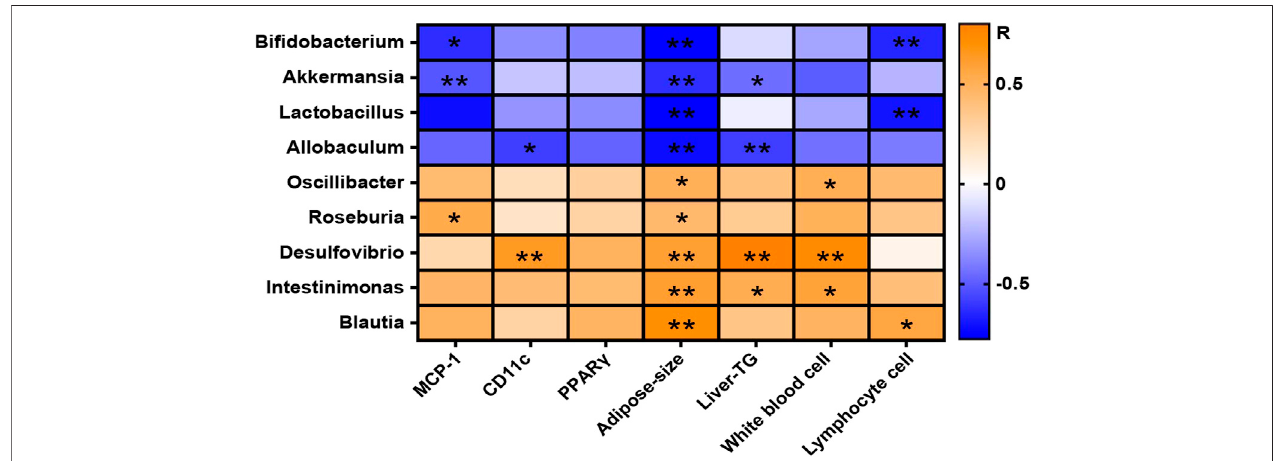
FIGURE 9 | Correlation between gut microbiota and physiochemical indices among experimental groups. After the treatment with NCD, HFD, and/or GlcN (1 mg/ ml, in drinking water) for 5 months, all mice were sacri fi ced and the cecal contents were collected for 16S rDNA sequencing. The correlation between changed gut microbiotaat thegenus level and physiochemical indiceswasdisplayed inaheatmap. Theorange-white-blue grid correspondedto the R -valueof0.5-0-( − 0.5).Orange color, positive correlation; blue color, negative correlation. Data were shown as means ± SEM ( n (cid:1) 5). * p < 0.05, ** p < 0.01.